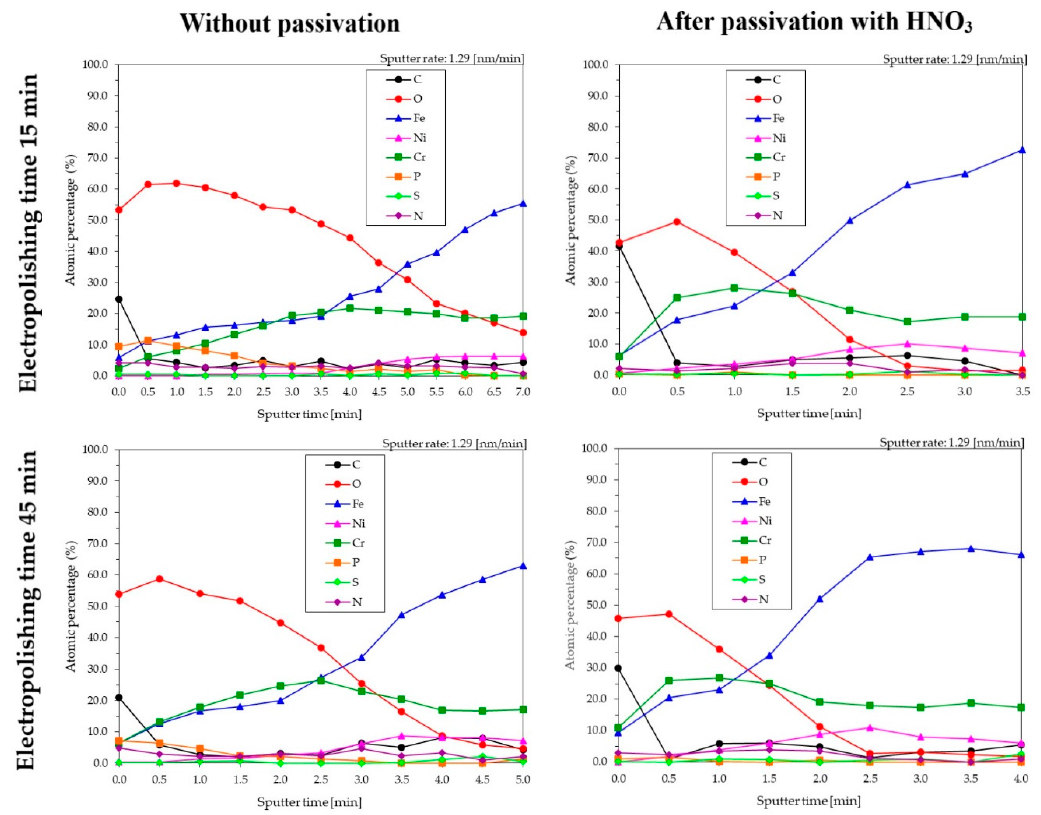
Figure 7. XPS depth profiles for chromium-nickel steel surface after electropolishing, samples prepared in laboratory scale S1-LAB.